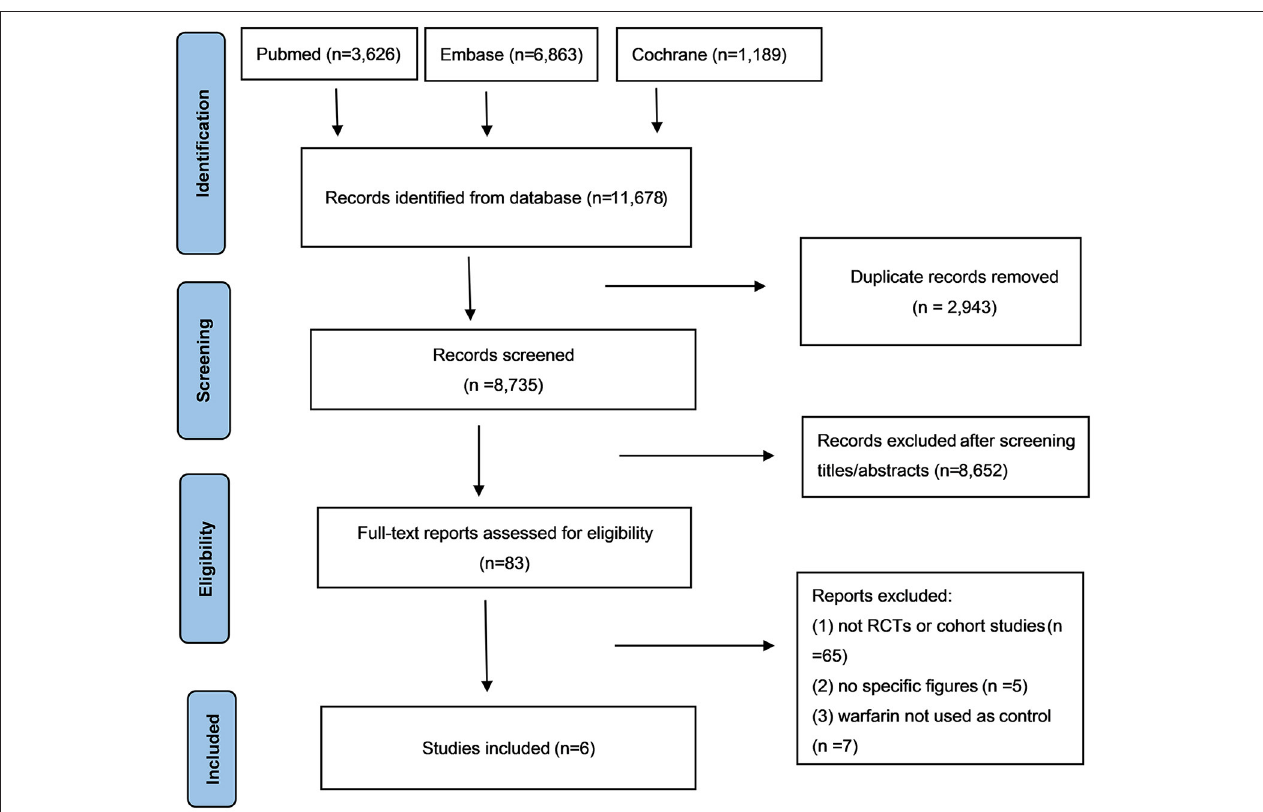
FIGURE 1 | The process of literature search of this meta-analysis. NOACs, novel oral anticoagulants; CI, confidence interval.